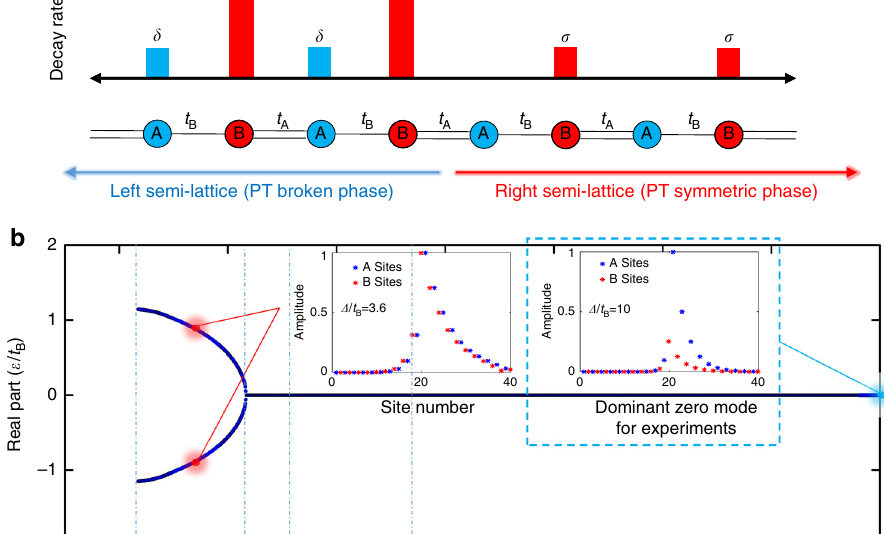
transition at the interface rather than the different topological orders in the two semi-lattices. This non-Hermitian-enhanced